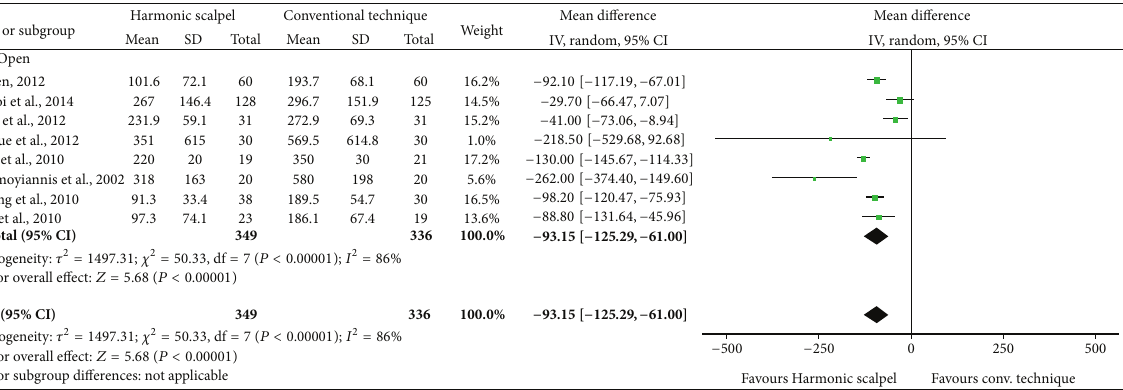
result from a publication selection bias; however, funnel plots did not indicate any clear omission of negative